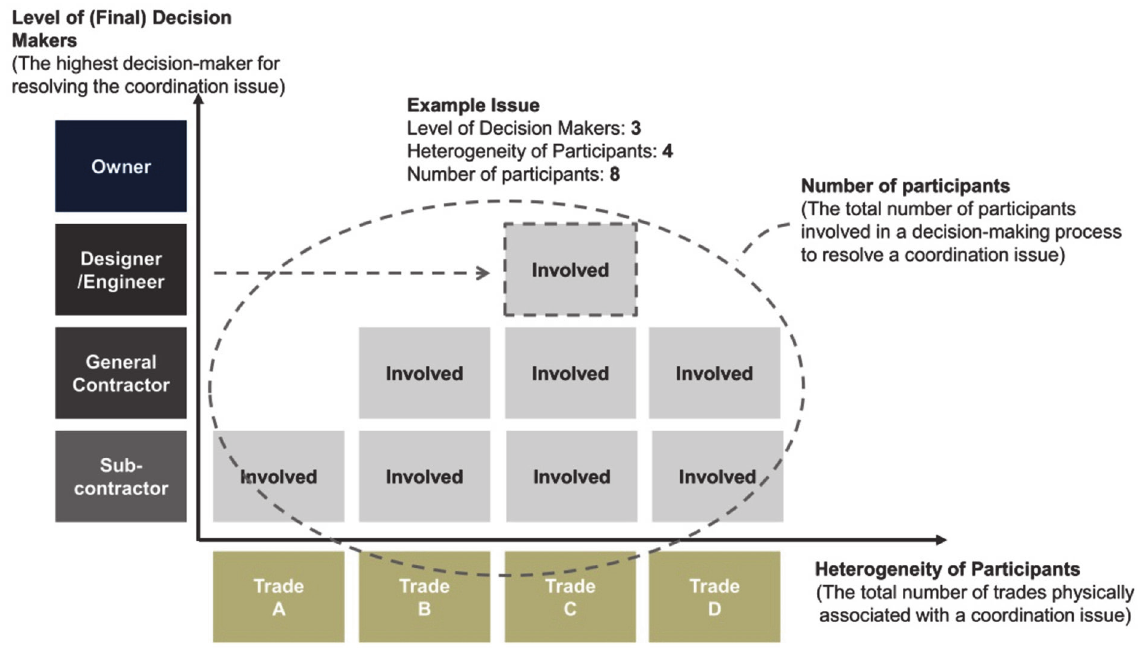
Figure 2. An example of the number of participants, the level of a decision maker, and the heterogeneity of participants in a